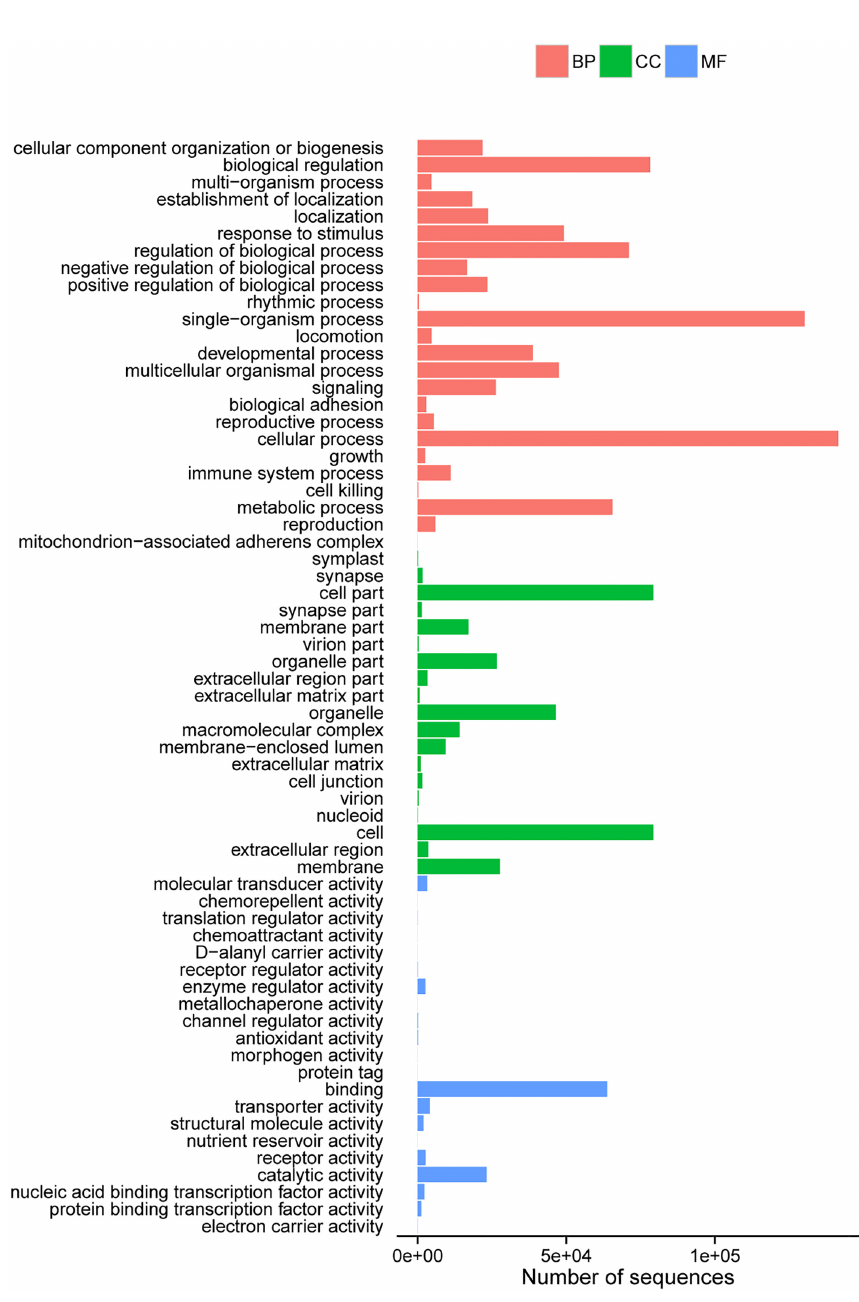
Fig 3. Histogram presentation of Gene Ontology classification. The results are summarized in three main categories: biological process, cellular component and molecular function. The y-axis on the right indicates the number of genes in a category. The y-axis on the left indicates the percentage of a specific category of genes in that main category.